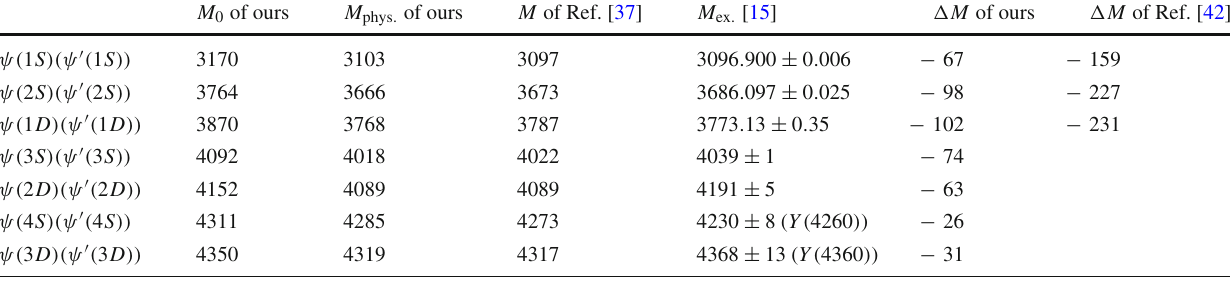
Table 1 Our theoretical results of bare masses, physical masses and mass shifts of vector charmonia. Experimental data and some theoretical predictions from literature are given for comparison. All quantities are given in the unit of MeV M 0 of ours M phys . of ours M of Ref.